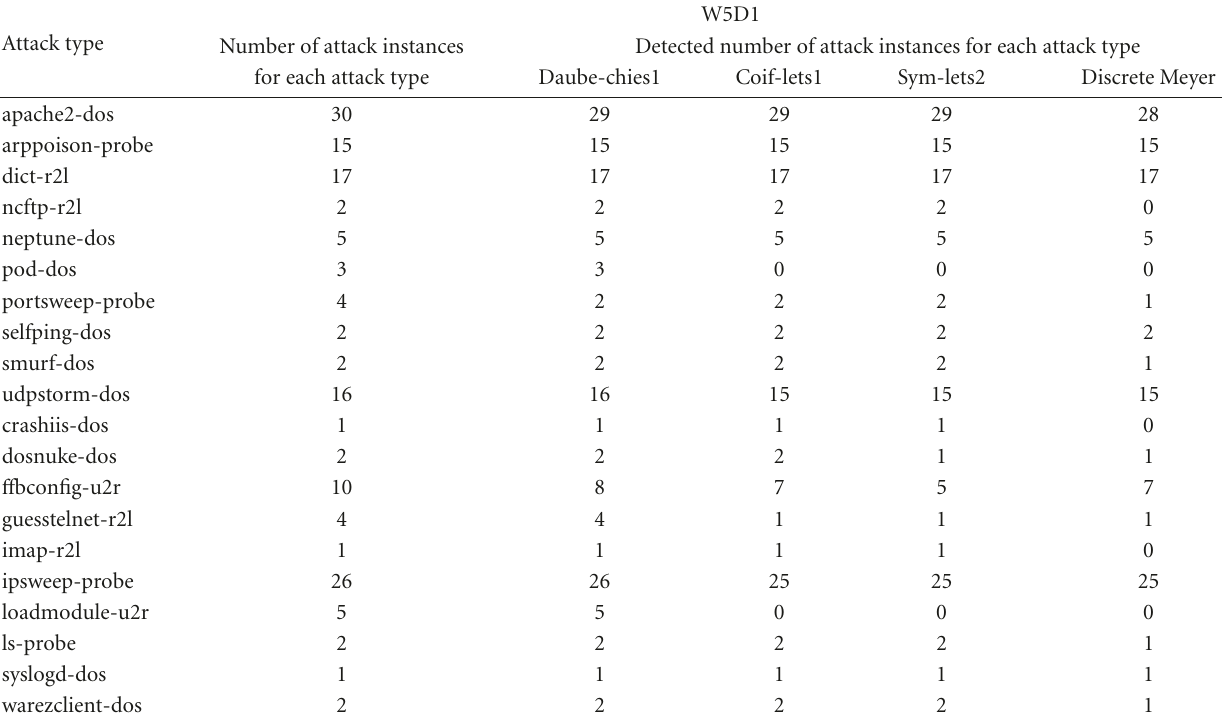
Table 7: Number of attack instances detected for each attack type by di ff erent basis functions.